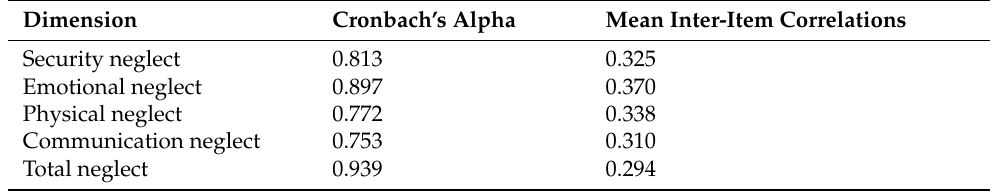
Table 3. CNS reliability ( n = 212).